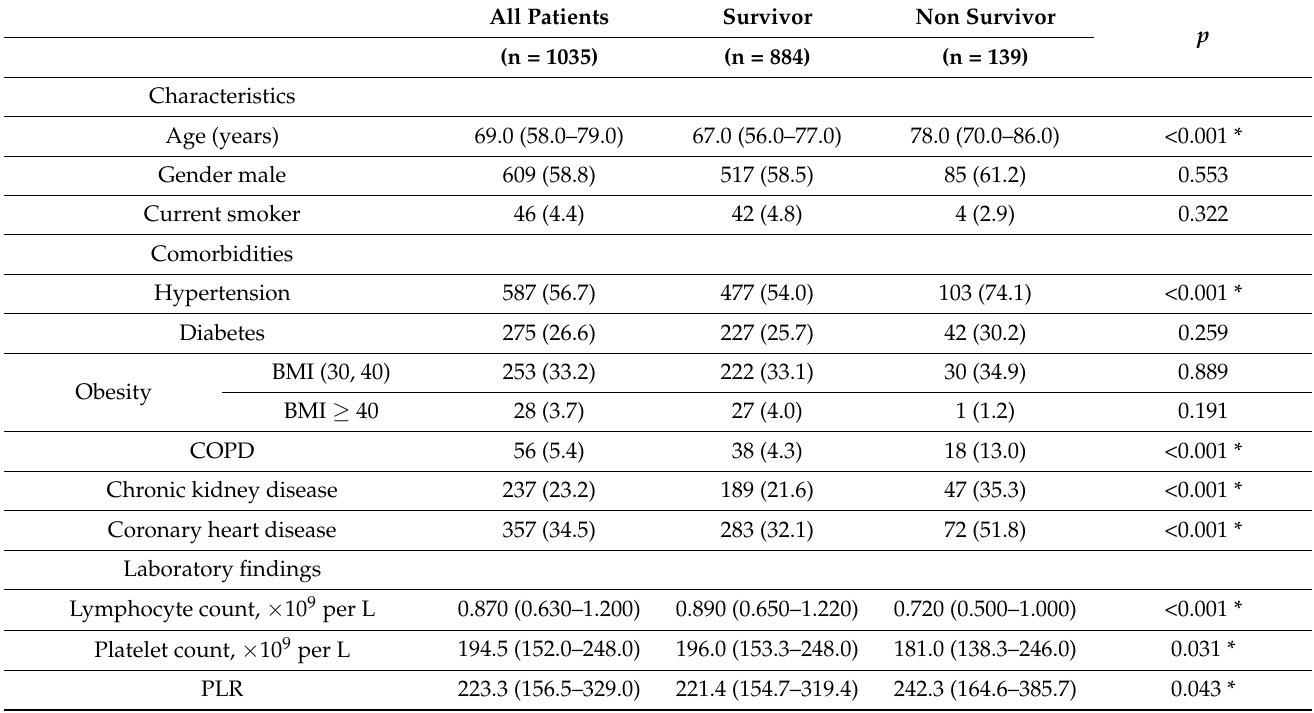
Table 2. General characteristics, comorbidities and laboratory findings of the study population, surviving and dying from